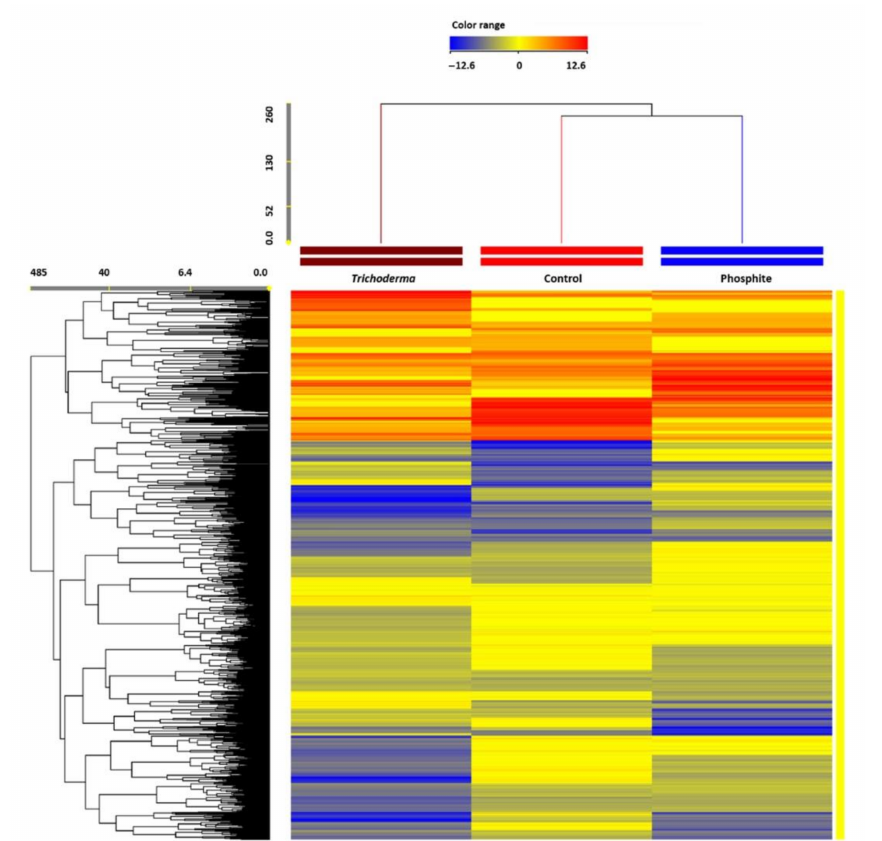
Figure 1. Unsupervised hierarchical cluster analysis (Euclidean distance; linkage rule: Ward) carried out from chemical profiles of plants treated with Trichoderma and phosphite. Metabolites were obtained by UHPLC-ESI/QTOF-MS untargeted analysis, and their normalized intensities were used to build up the heatmaps.